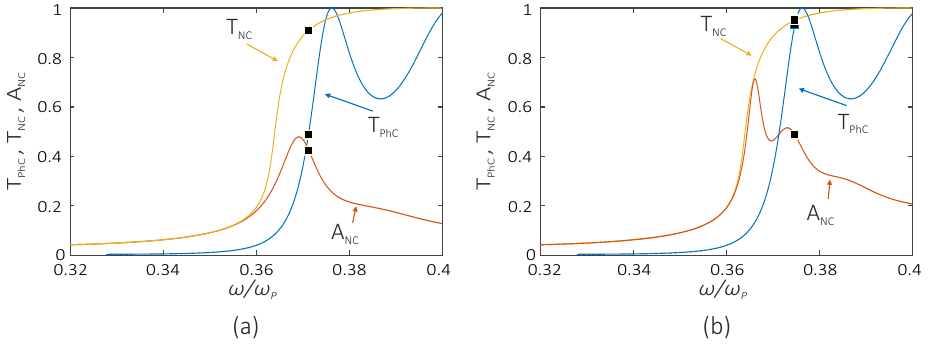
Figure 11. Graphic solution of the critical coupling condition in Equation (10) at a nanocomposite layer thickness of 341 nm ( a ) and 576 nm ( b ). The nanocomposite filling factor is f = 0.25.